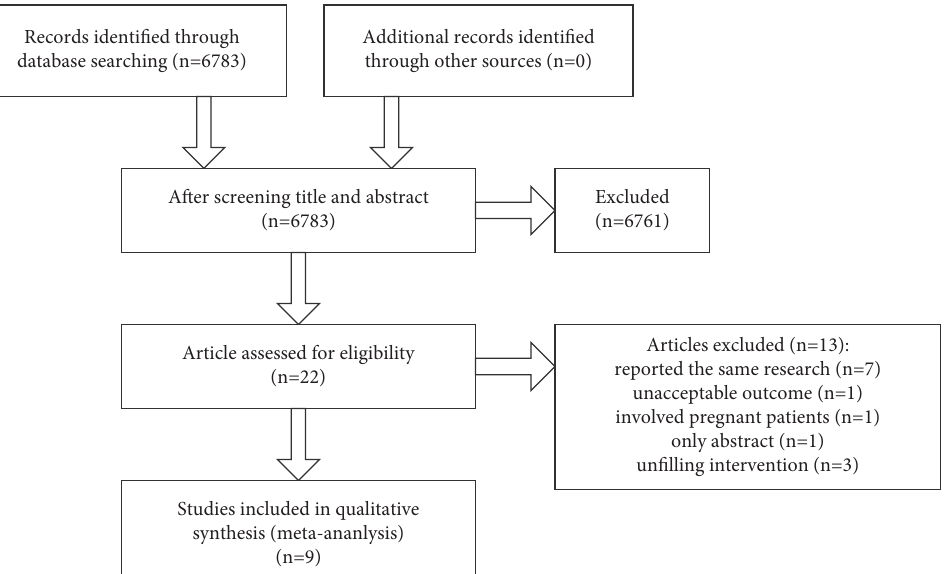
Figure 1: Flowchart showing selection of articles for